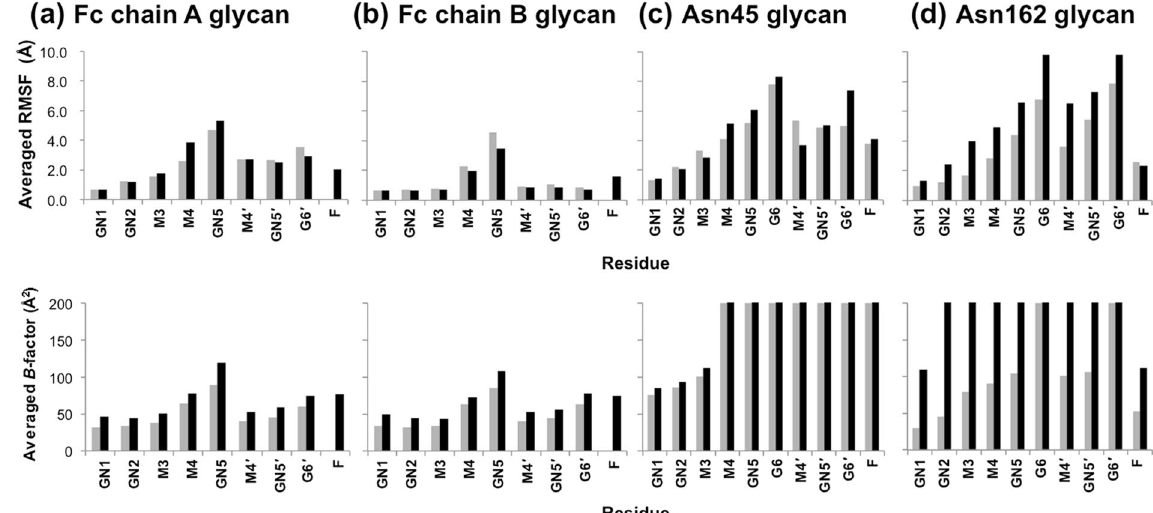
Figure 3. RMSF and crystallographic B -factor values for sugar residues of N -glycans of IgG1-Fc and Fc γ RIIIa. Averaged RMSF and crystallographic B -factor of each residue in the IgG1-Fc/Fc γ RIIIa complexes are shown in the upper and lower panels, respectively: ( a ) Fc chain A glycan; ( b ) Fc chain B glycan; ( c ) Asn45 glycan; ( d ) Asn162 glycan. The values of the nonfucosylated and fucosylated systems are shown as gray and black bars, respectively. The B -factor values of crystallographically disordered residues are indicated as 200 Å 2 . The residues are designated as follows: GlcNAc1 (GN1); GlcNAc2 (GN2); Man3 (M3); Man4 (M4); GlcNAc5 (GN5); Gal6 (G6); Man4 ′ (M4 ′ ); GlcNAc5 ′ (GN5 ′ ); Gal6 ′ (G6 ′ ); Fuc (F).